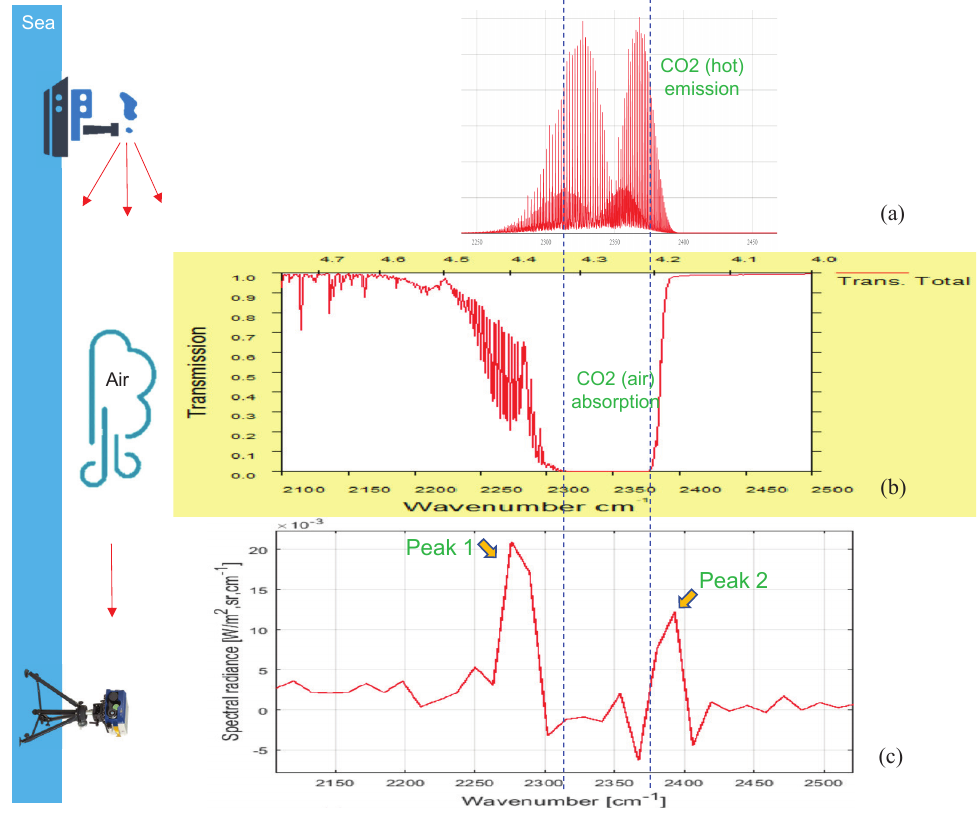
Figure 1. Operational concept of remote ship detection and the double spike-signature generation mechanism of hot carbon dioxide: ( a ) spectrum of a hot CO 2 emission by a ship, ( b ) spectral atmospheric transmittance, and ( c ) received spectral radiance of hot CO 2 from a ship’s plume. The measurement of CO 2 -double spikes can be derived from radiative transfer calculated with Equation (1). We adopted the radiative-transfer equation used in the Moderate-Resolution Atmospheric Radiance and Transmittance (MODTRAN) [41]. In general, at-sensor received radiance in the midwave infrared (MWIR) region consists of CO 2 -emitted radiance, transmitted background radiance, and total atmospheric path radiance (thermal+solar